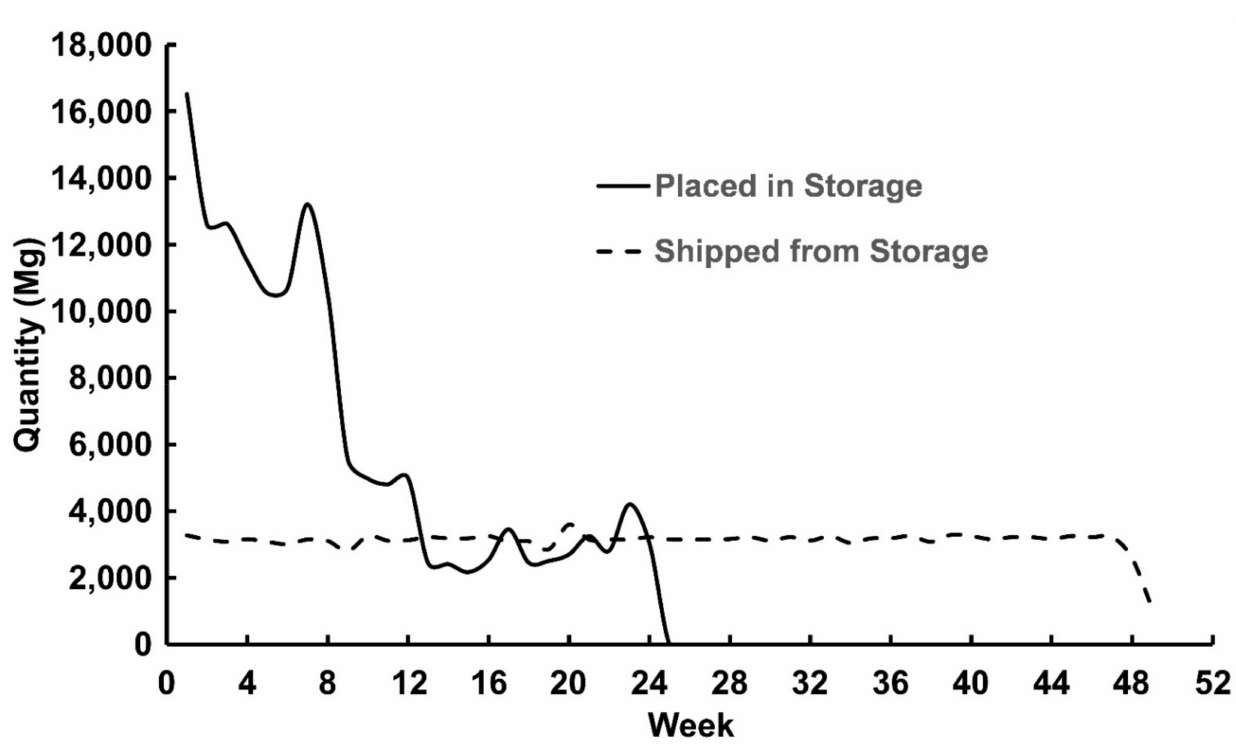
Figure 5. Total feedstock (over all 199 SSLs) placed in storage over a 24-week harvest season and delivered for a 49-week operation using the eight-load-out simulation.